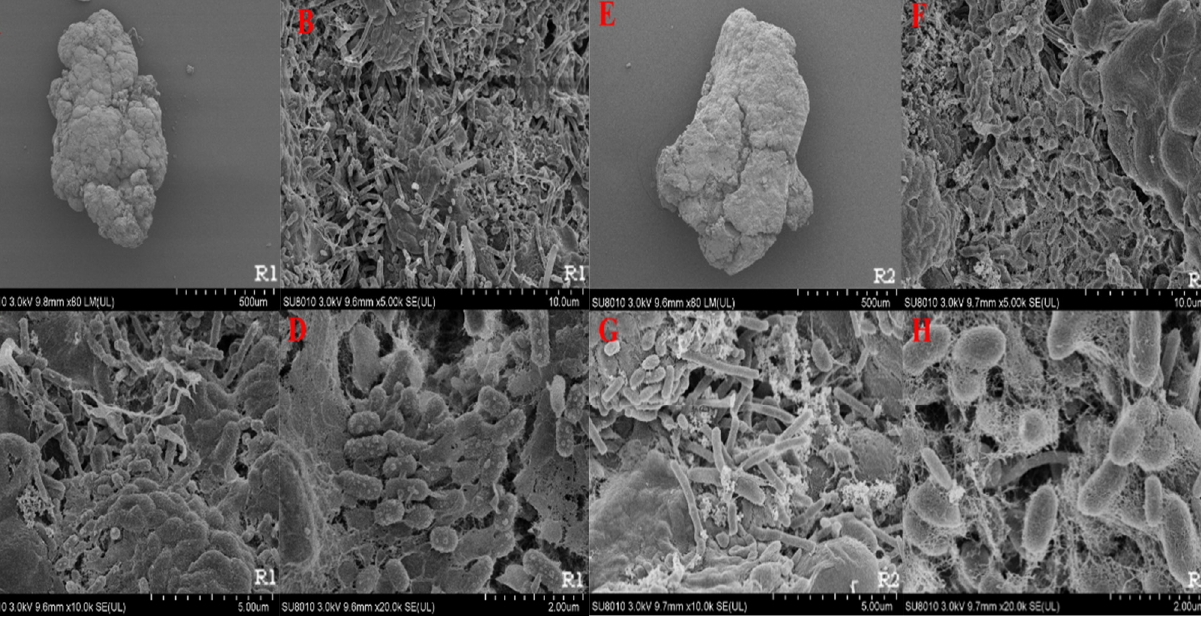
Figure 2. SEM of the aerobic granules in R1 and R2. ( A – D ), in R1; ( E – G ), in R2.